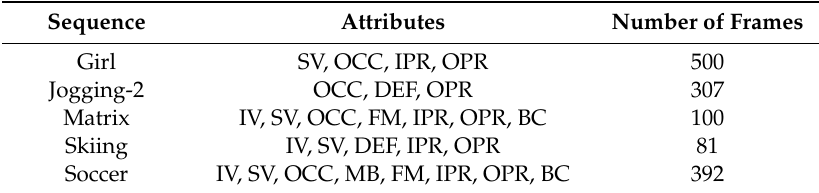
Table 7. Attributes of test video sequences on OTB2013.